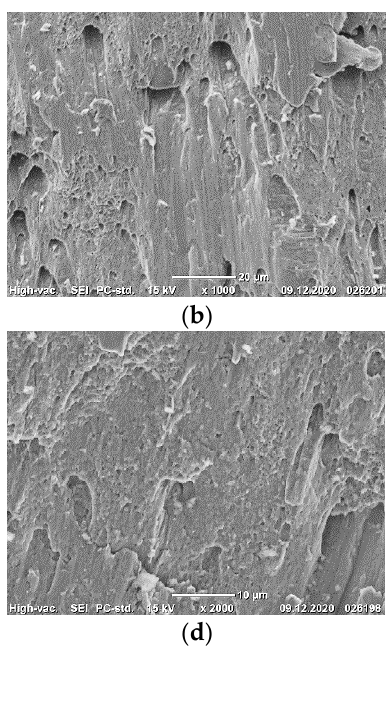
Figure 4. Typical view of the fracture surface of the steel specimen during torsion: ( 1 ) central part, ( 2 ) transition (middle) part, and ( 3 ) peripheral part.